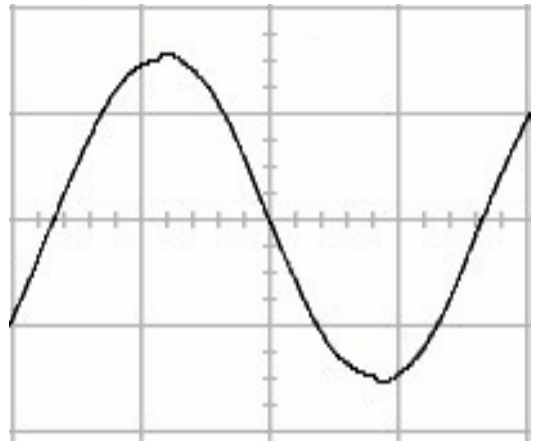
Figure 17. Experimental AC output voltage for the proposed method under a sudden removal of load (vertical: 100 V/div and 5 ms/div).